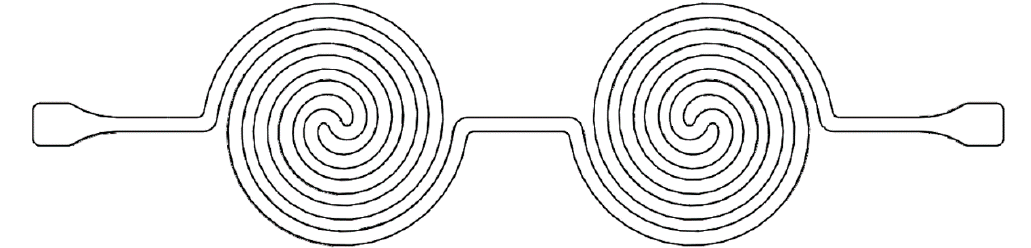
Figure A16. Spiral Fabric Design DS-5. Double spiral design, polyester tape.